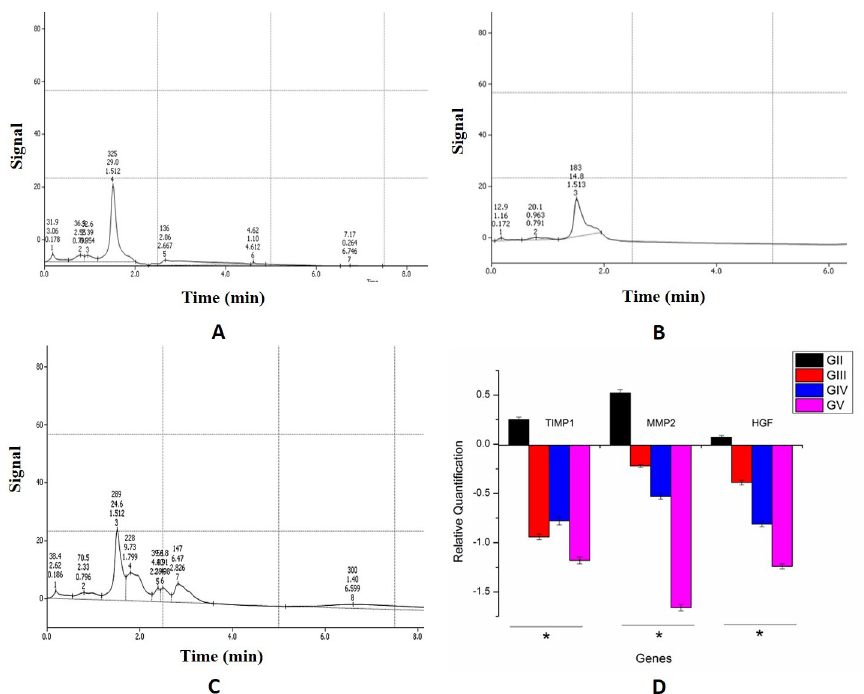
Fig 1. HPLC profile with retention time of quercetin compound from fruit extracts of (A) Diospyros malabarica and (C) Gynocordia odorata fruit extracts. (B) Profile of standard quercetin molecule. (D) Gene expression profile in real time PCR of quercetin on Group D and E rats.